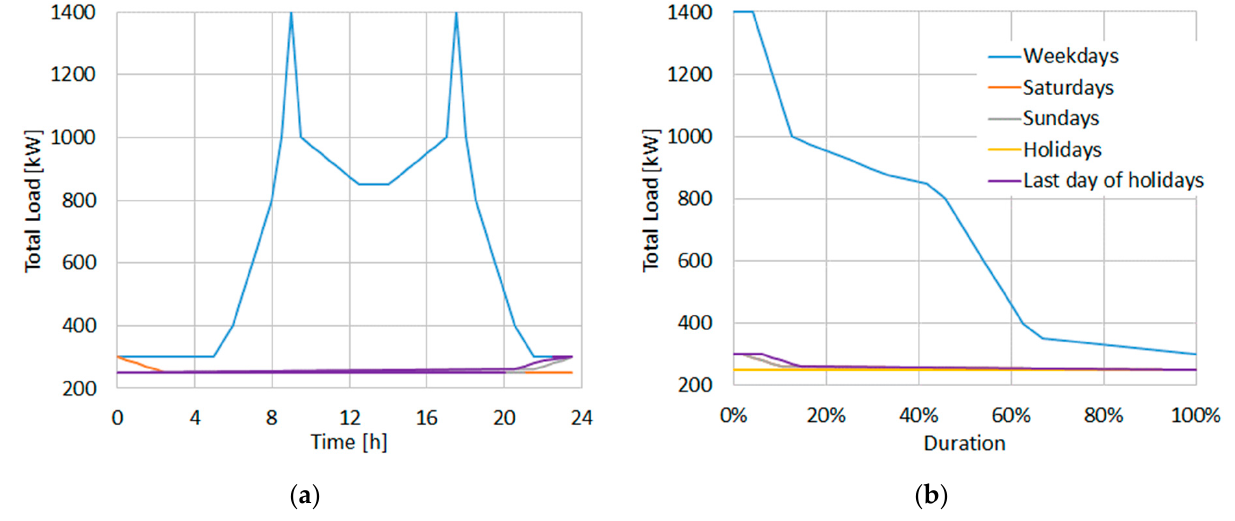
Figure 6. Load profile of ship: ( a ) versus time; ( b ) load duration curve.